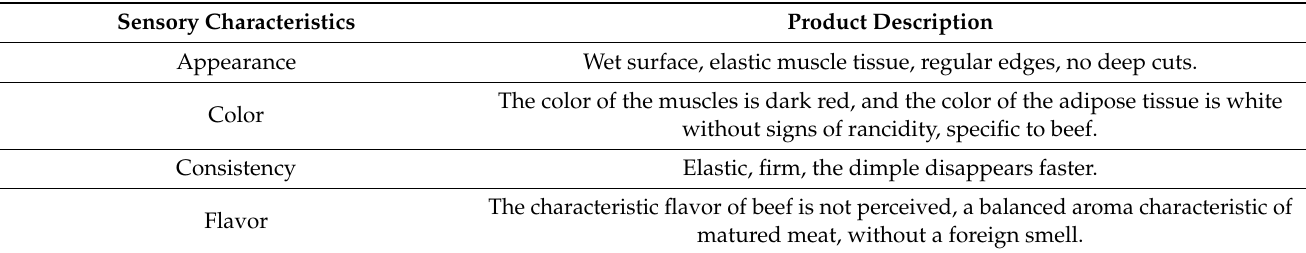
Table 1. Sensory characteristics for the evaluation of the finished product. Sensory Characteristics Product